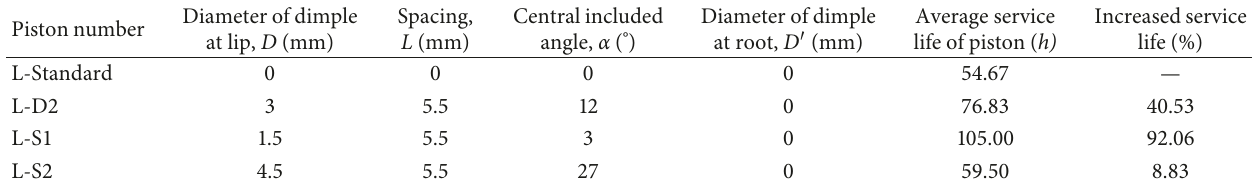
Table 2: Influence of central included angle on piston service life.